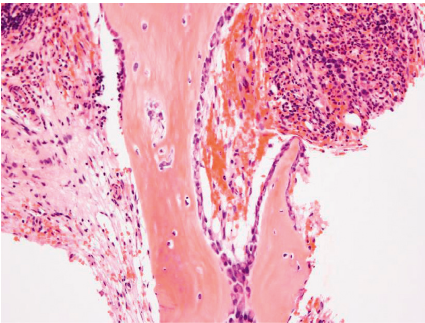
Figure 6: Multilayered osteoblasts in the bone marrow after in- duction chemotherapy. Osteoblasts multilayered along the tra- becular bone. Magnification,